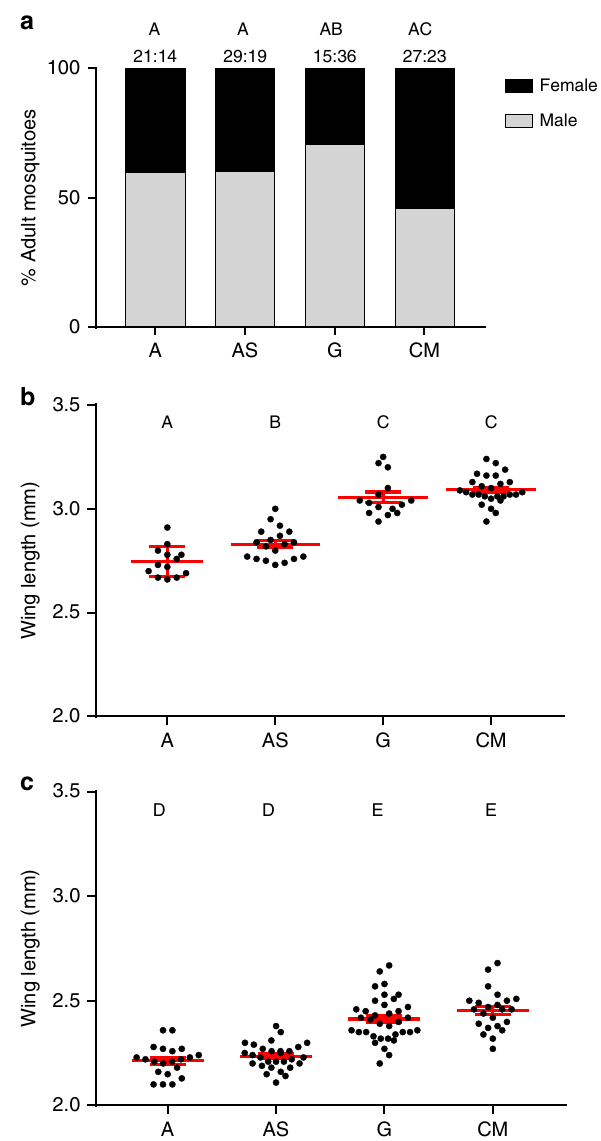
Fig. 4 Biometric assessment of adult mosquitoes. a Male:female ratio for axenic (A), axenic supplemented with heat-killed E. coli (AS), gnotobiotic (G), and colony microbiome (CM) mosquitoes. Bars marked with a different letters were signi fi cantly different in sex ratio with a P -value < 0.05 by Fisher ’ s Exact test. The number of mosquitoes assayed is indicated above the bars. b Female wing length. c Male wing length. Points represent wing lengths of individual mosquitoes ( n = 54). Mean wing length and standard error of all individuals are signi fi ed by the red bars. The numbers of mosquitoes assayed are the same as indicated in panel A. Columns labeled with different letters were signi fi cantly different with a P - value of < 0.05 as determined by a one-way analysis of